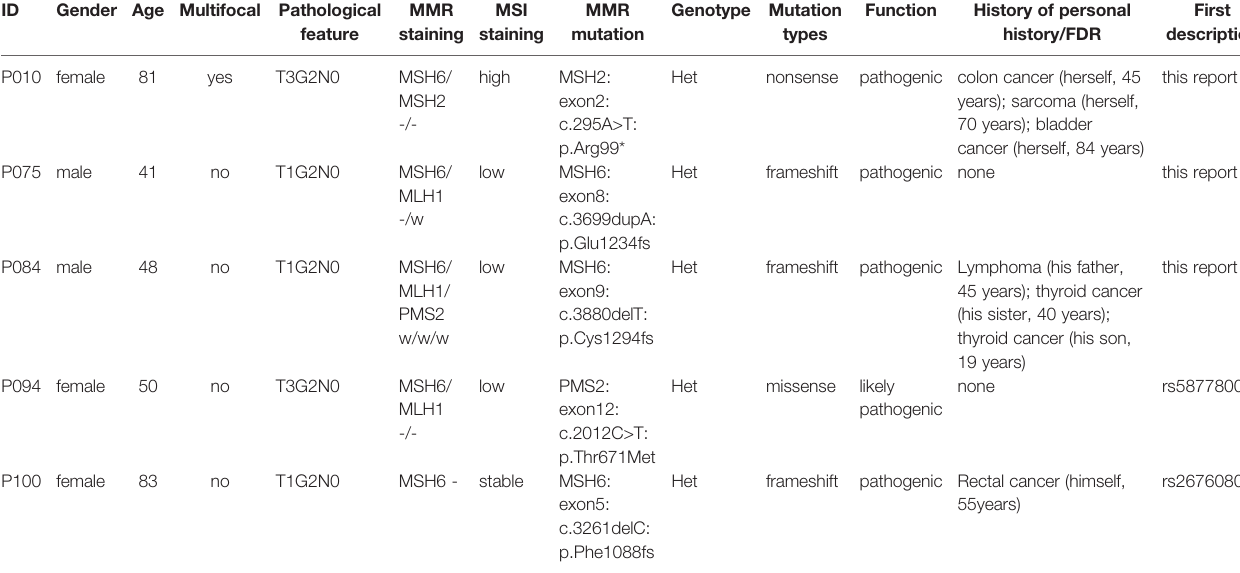
TABLE 1 | Germline likely pathogenic/pathogenic MMR mutations in 38 patients who underwent whole exon